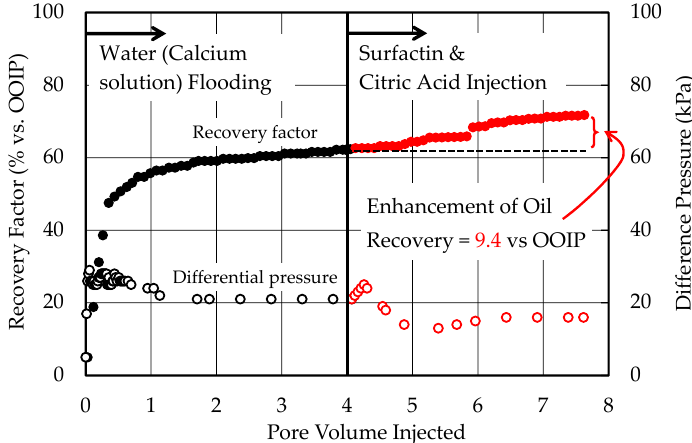
Figure 8. Temporal change in the recovery factor and differential pressure during the core flooding experiment using the more permeable oil reservoir.